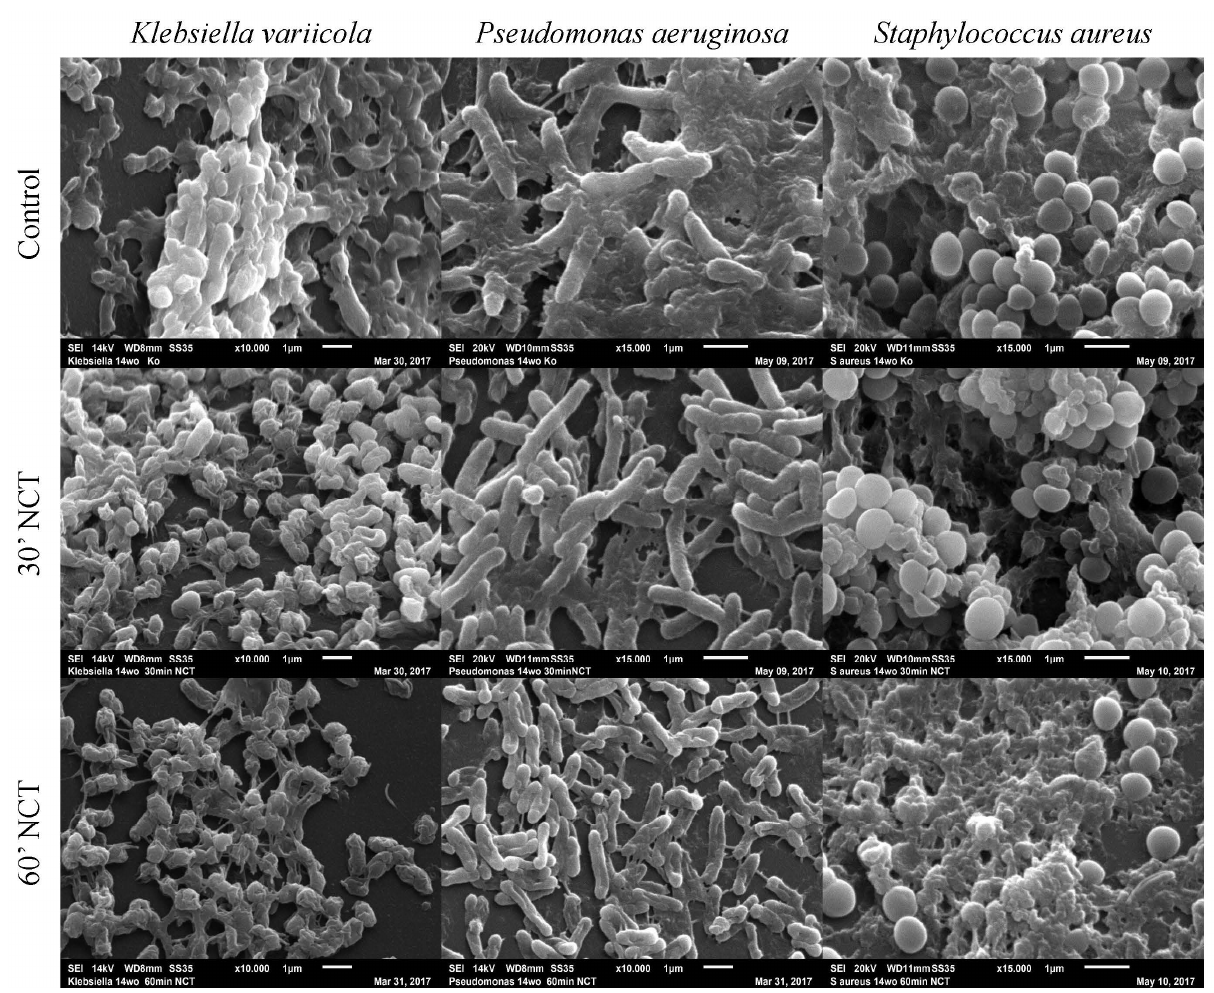
Figure 9. Scanning electron microscopy of 14-week-old Klebsiella variicola , Pseudomonas aeruginosa , and Staphylococcus aureus biofilms. Upper row: mock-treated control biofilms (Magnification: K. variicola 10,000 × ; P. aeruginosa and S. aureus 15,000 × ); middle row: biofilms treated with NCT, for 30 min (Magnification: K. variicola 10,000 × ; P. aeruginosa and S. aureus 15,000 × ); lower row: biofilms treated with NCT for 60 min (Magnification: K. variicola and P. aeruginosa 10,000 × ; S. aureus 15,000 ×